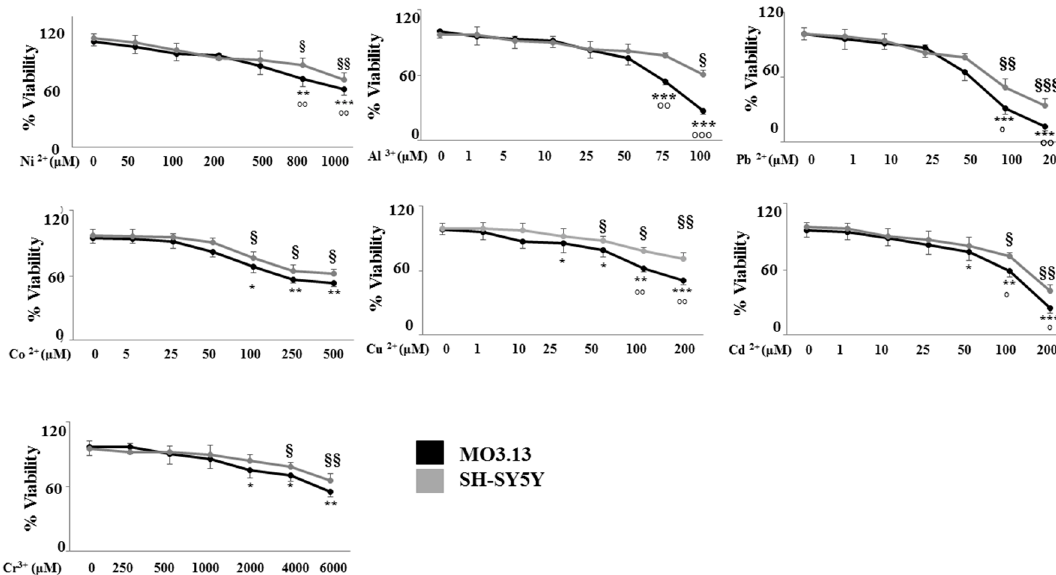
Figure 3. Analysis of cell viability of oligodendrocytes and neurons, grown separately, after the treatment with di ff erent concentrations of heavy metals. Human di ff erentiated oligodendrocytes (MO3.13) and human neurons (SH-SY5Y) were grown separately and treated with heavy metals for 24 h at the concentrations reported in the figure. The cell viability was measured through 3-(4,5-dimethylthiazol-2-yl)-2,5-diphenyltetrazolium bromide (MTT) assay. Values of three independent experiments are expressed as mean ± standard deviation (sd). * denotes p < 0.05 vs. control; ** denotes p < 0.01 vs. control; *** denotes p < 0.001 vs. control. § denotes p < 0.05 vs. control; §§ denotes p < 0.01 vs. control; §§§ denotes p < 0.001 vs. control; ◦ denotes p < 0.05 vs. oligodendrocyte viability under the same treatment conditions; ◦◦ denotes p < 0.01 vs. oligodendrocyte viability under the same treatment conditions; ◦◦◦ denotes p < 0.001 vs. oligodendrocyte viability under the same treatment conditions. Analysis of Variance (ANOVA) followed by the Tukey-Kramer comparisons test.